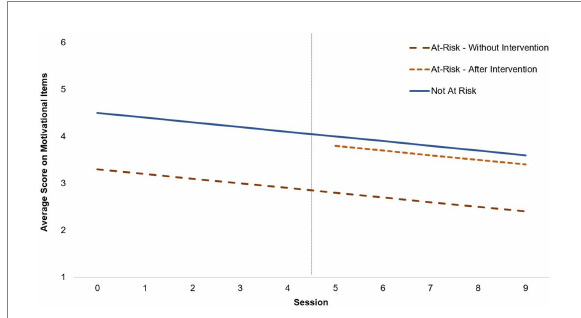
FIGURE 3 Expected pattern of results due to the intervention group, session, and interaction between intervention group and leap variables over time. Time of intervention indicated by dotted line.